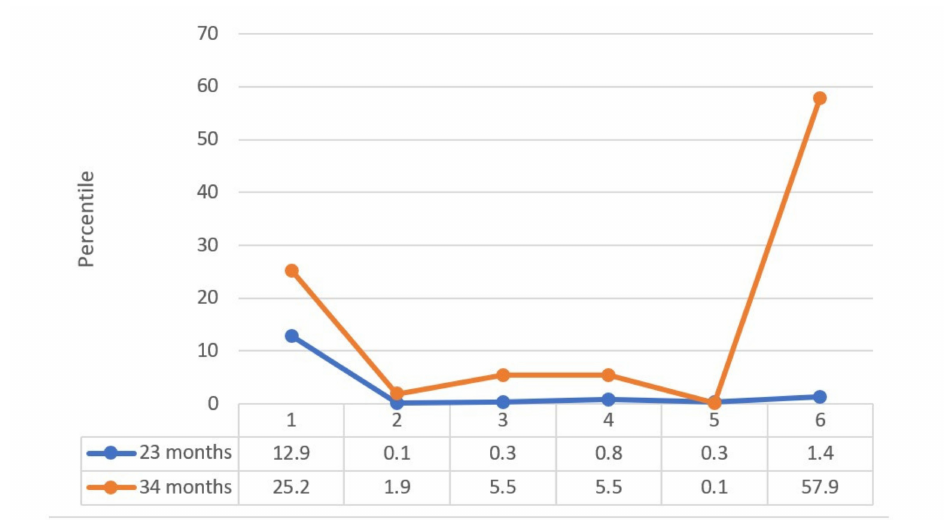
Figure 3. Scores of the cognitive battery of the Merrill–Palmer developmental scale.